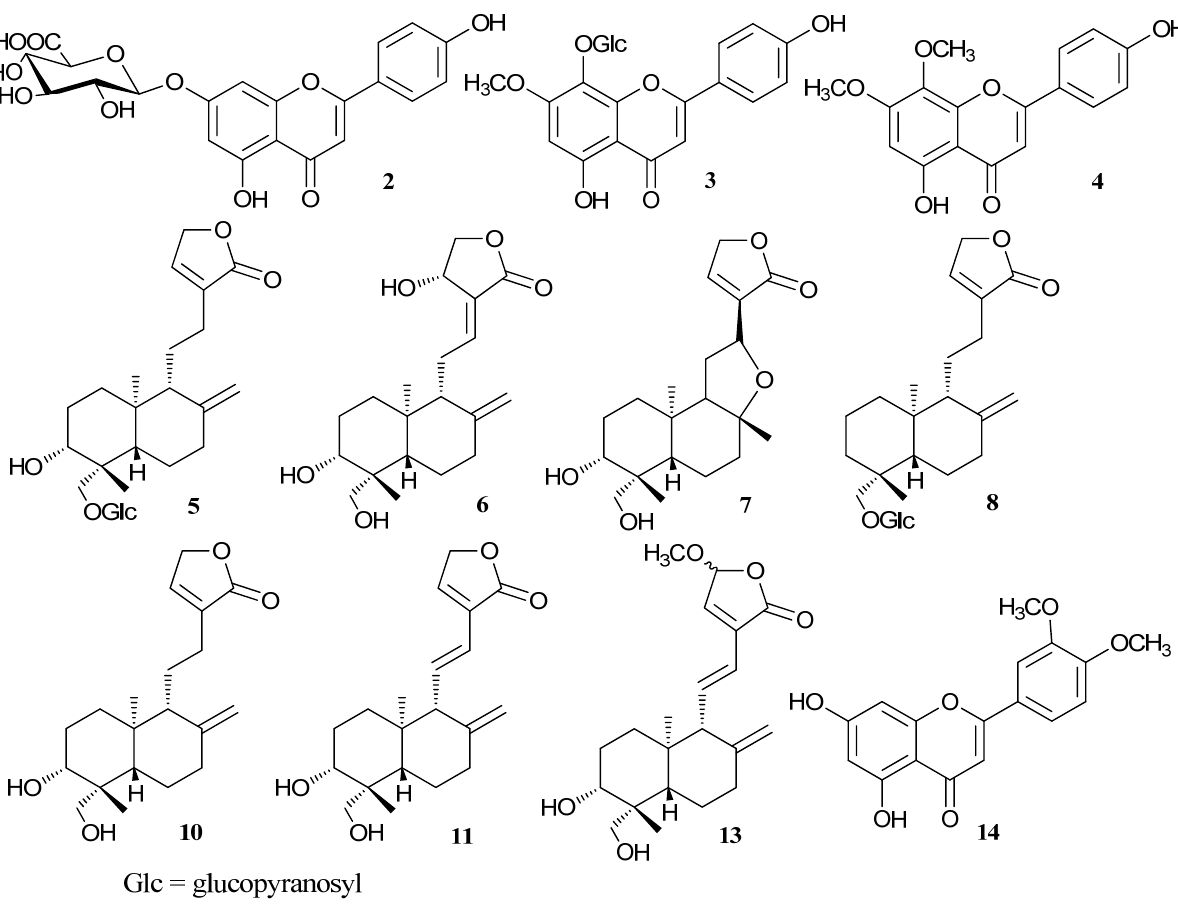
Figure 1. The structures of compounds identified in Andrographis